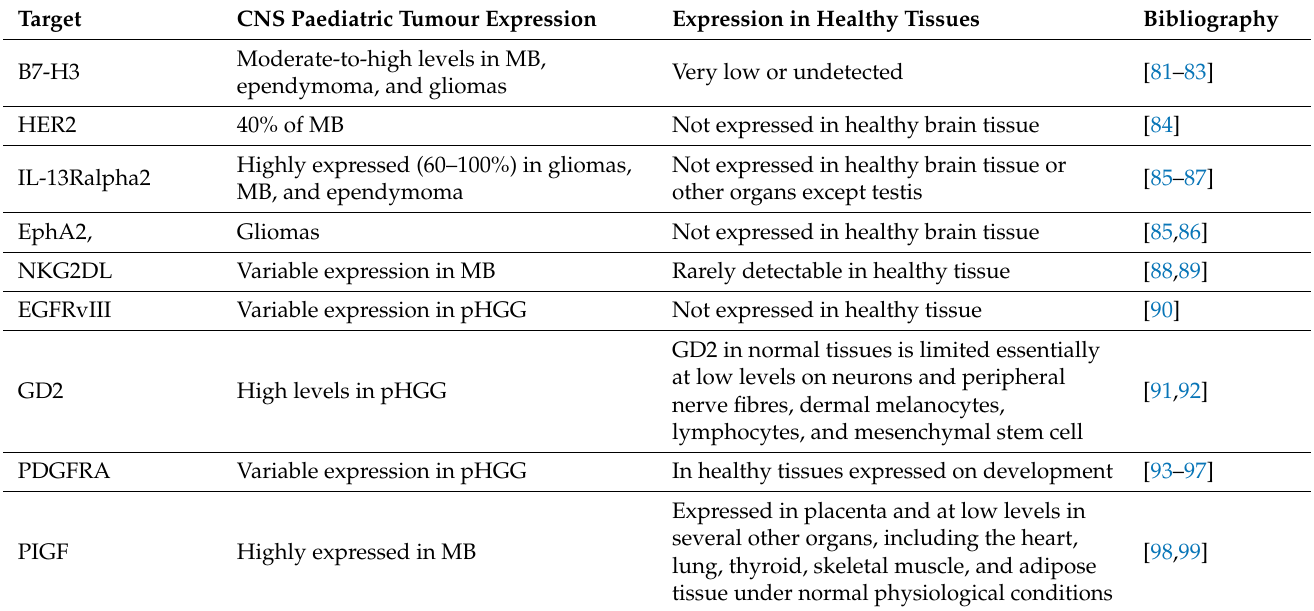
Table 2. Most common tumour antigens for CNS paediatric brain tumours. Expression in Healthy